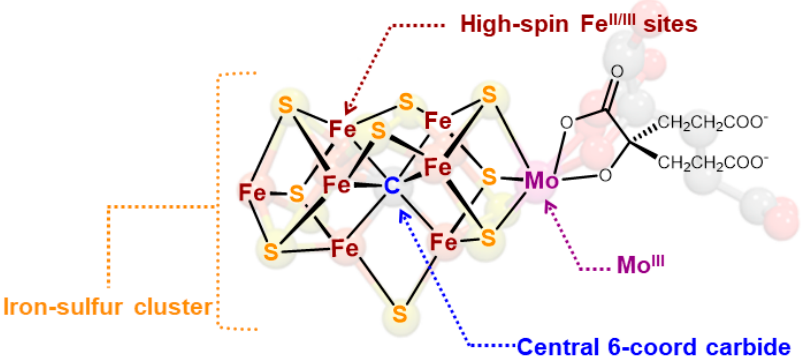
Figure 6. Target structural and electronic attributes of interest in FeMoco for biomimetic modelling.